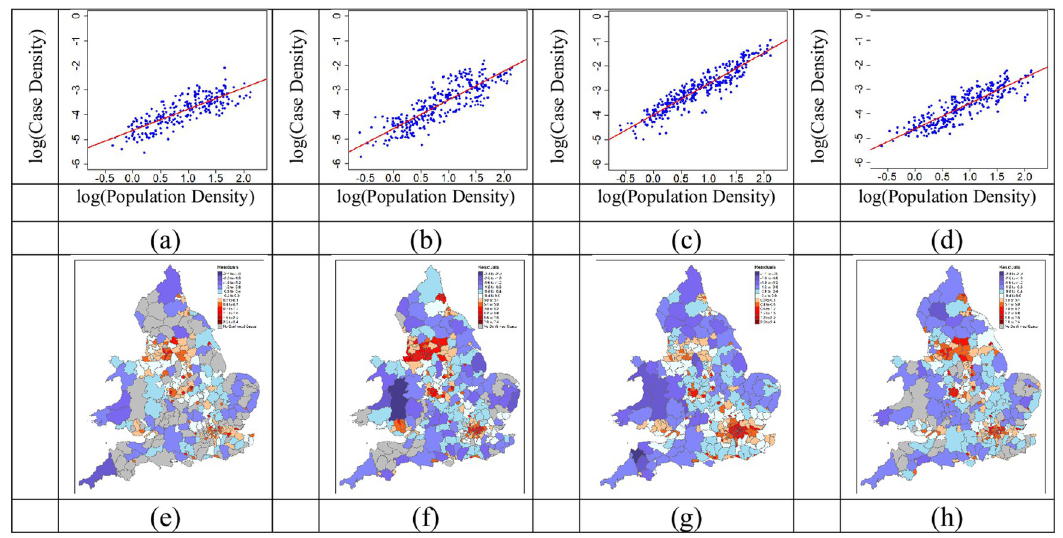
Fig 3. Scaling plots and geoplots at different times during the pandemic. These are recorded on the (a and e) 08/06/2020. (b and f) 16/09/2020. (c and g) 25/12/2020. (d and h) 04/04/2021. Regions that are red are above expectation and blue is below. The darker the shade the further from the scaling law. The geomaps contain public sector information licensed under the Open Government Licence